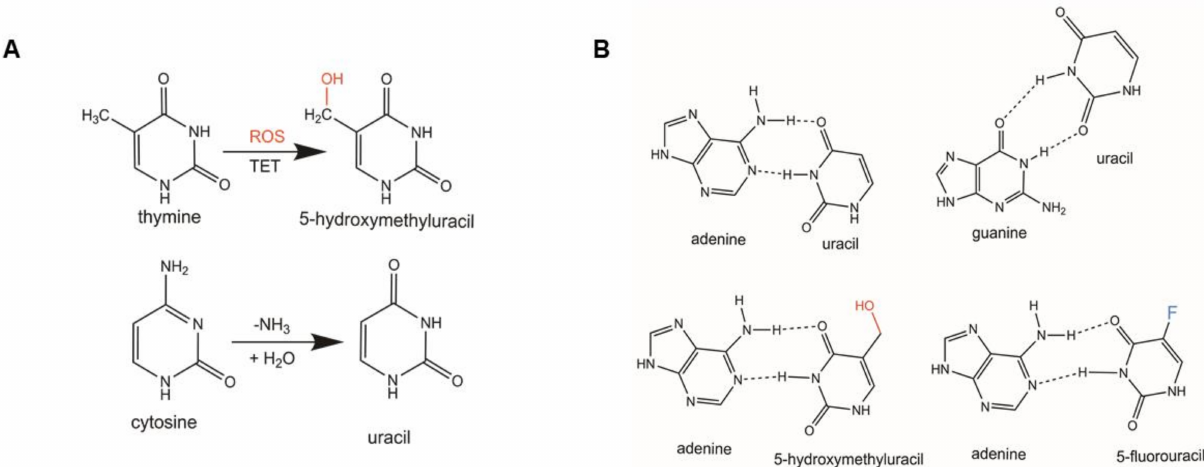
Figure 1. Generation of 5-hmdU and structures of pertinent SMUG1-targeted oxidative lesions. Chemical structures of SMUG1 lesions. ( A ) Formation of pertinent SMUG1 lesions: 5-hydroxymethyluracil (5-hmU) after oxidation of thymine by reactive oxygen species (ROS) or ten-eleven translocation (TET) enzymes. ( B ) Base pairings of SMUG1 target substrates. The hydroxyl moiety generated by ROS is highlighted in